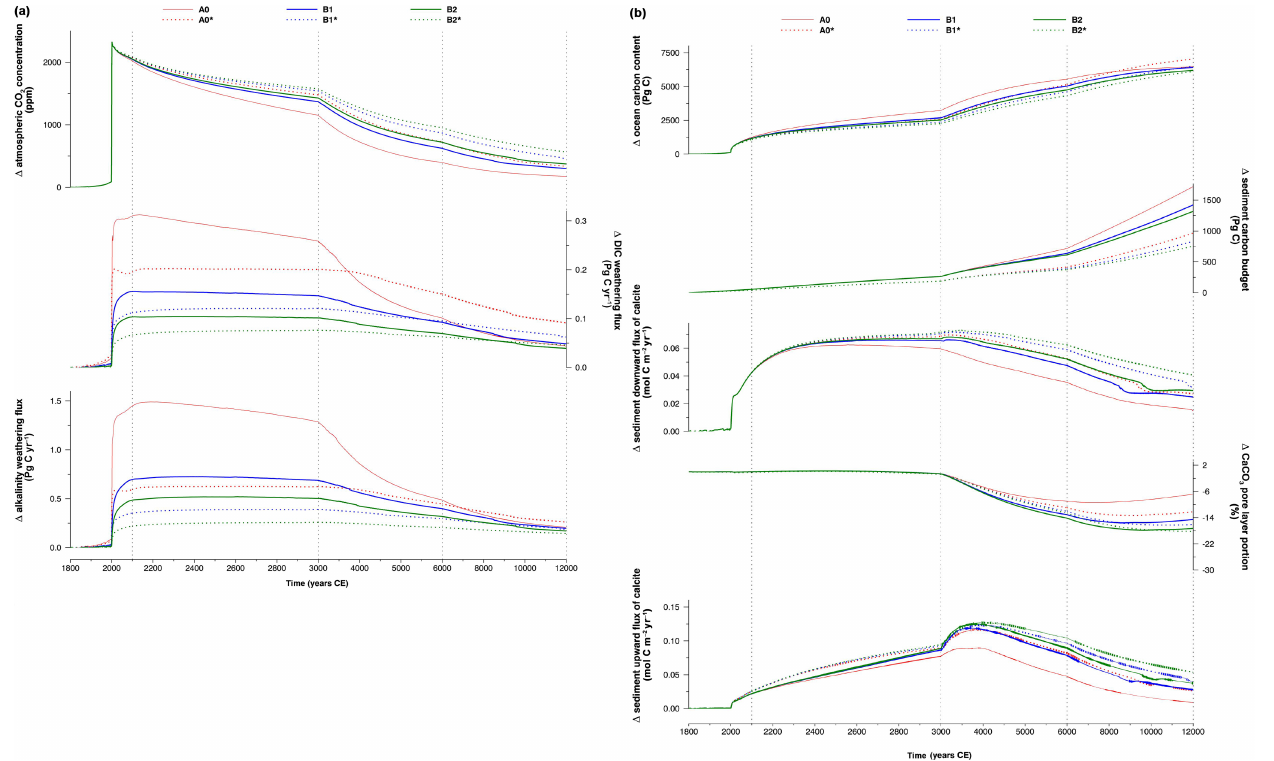
Figure 6. Time series of simulated changes in various model outputs for Group B scenarios, compared with pre-industrial steady-state values. These scenarios include A0 (dependence on temperature, NPP, and runoff), B1 (dependence on temperature, atmospheric CO 2 , and runoff), and B2 (dependence on temperature and runoff only), as well as their zero-dimensional counterparts (indicated by the “ ∗ ” symbol). Shown here are (from top to bottom) (a) atmospheric CO 2 concentrations and weathering fluxes of DIC and alkalinity, and (b) oceanic carbon difference, sediment carbon difference, downward flux of calcite into sediments, calcite pore layer portion, and dissolution of calcite in sediments. Note the different scales along the time axis, which change at years 3000 and 6000. Vertical dashed lines are used to indicate times for which results are shown in Figs. 4, 5, and 7. The curves shown here represent experiments A0 (red), B1 (blue), and B2 (green), with dashed colored lines representing the zero-dimensional equivalent model